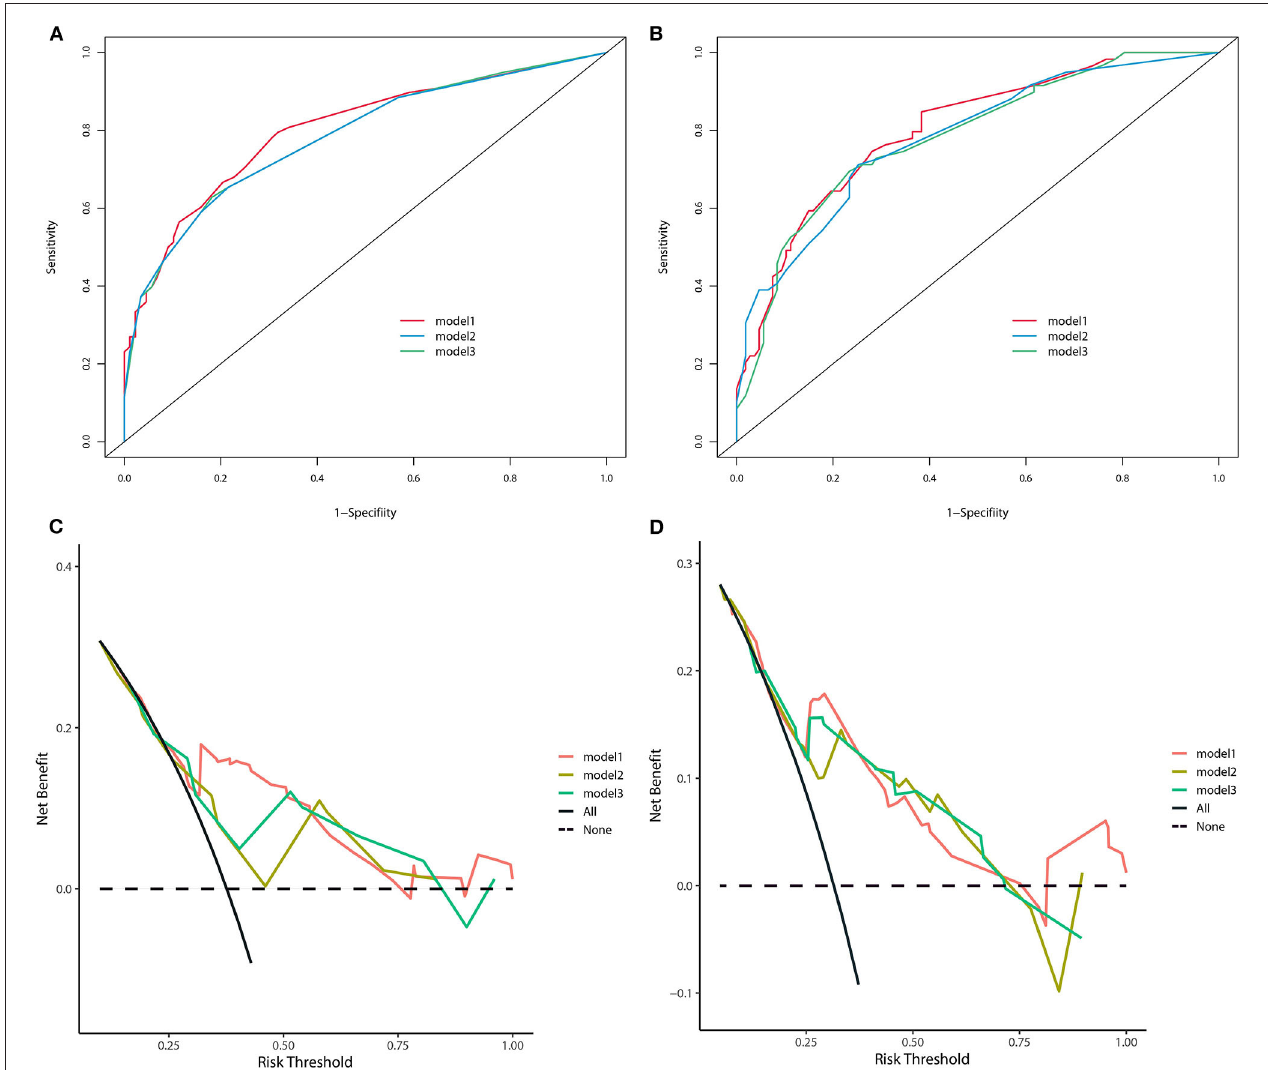
FIGURE 3 | The receiver operating curve of three nomogram models in the training cohort (A) for OS and (B) for CSS. Decision-curve analyses demonstrating the net benefit associated with the use of the models (C) for OS and (D) for